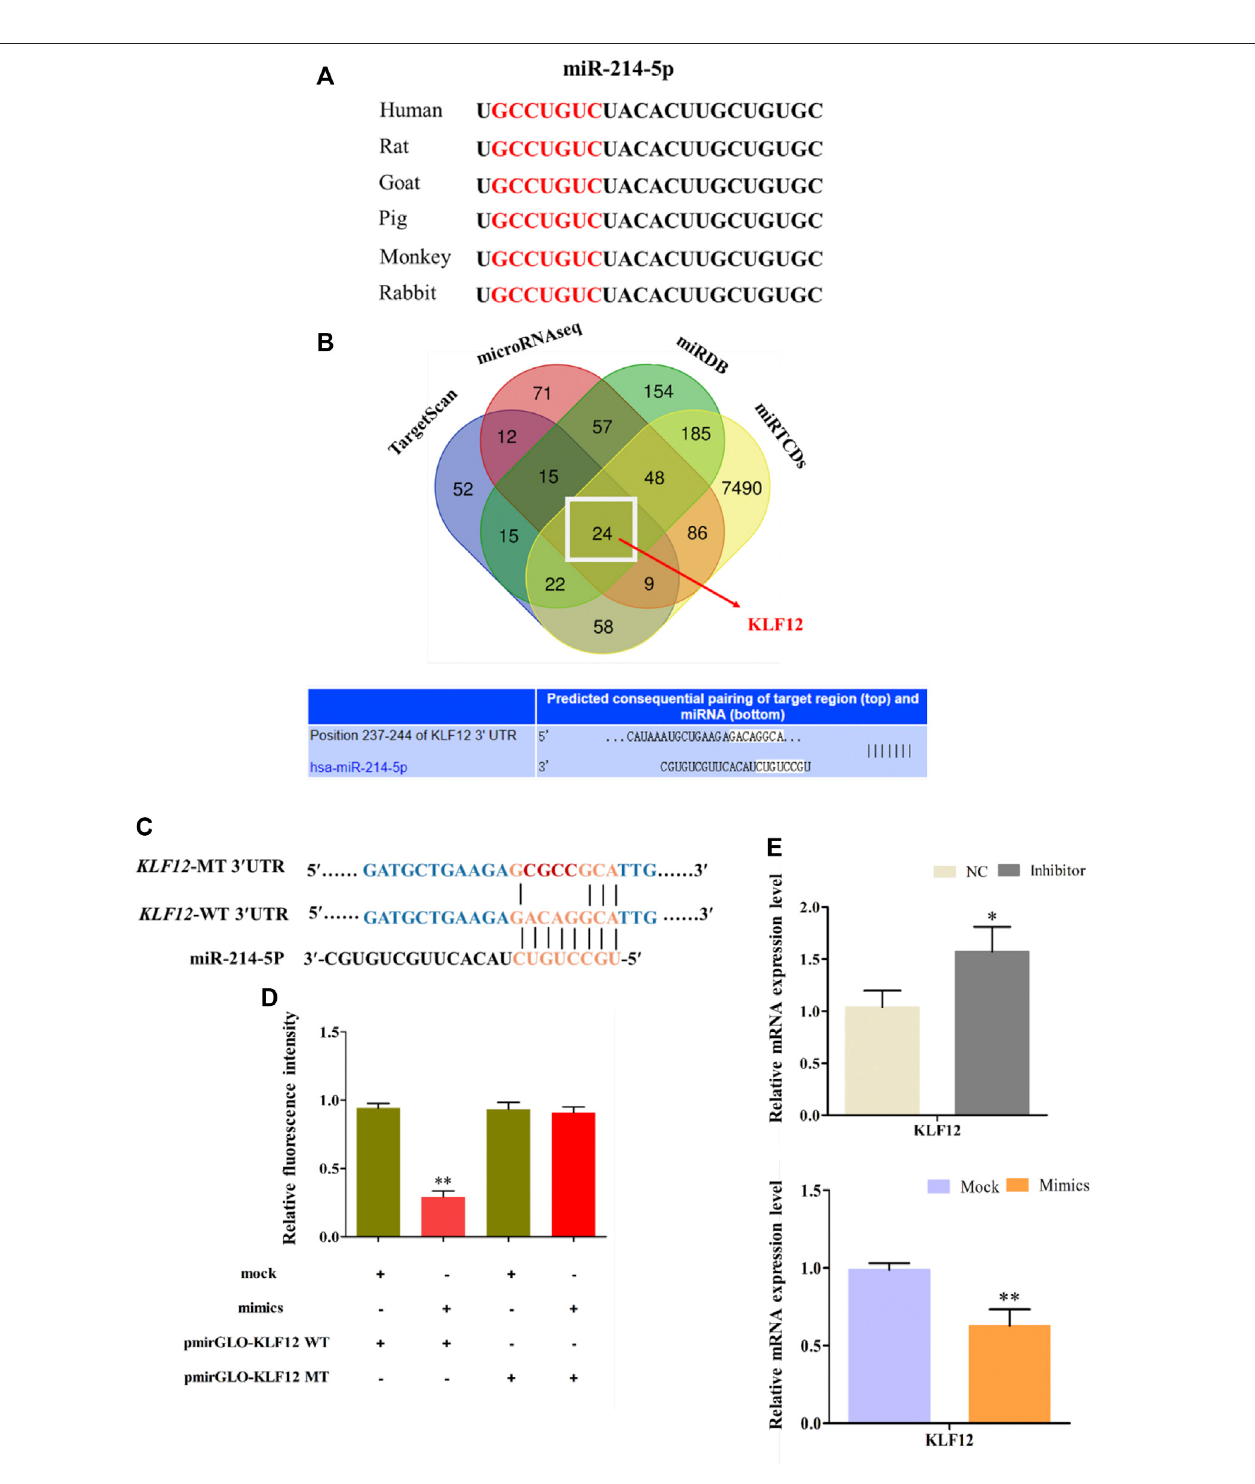
FIGURE 4 | KLF12 as a target gene of miR-214-5p. (A) Seed sequences of miR-214-5p. (B) Predicting of miR-214-5p target genes. (C) Sequence of KLF 12 3 ′ UTR wide type and mutation type. (D) Result of dual luciferase reporter experiment. (E) Effect of miR-214-5p on KLF 12 expression.